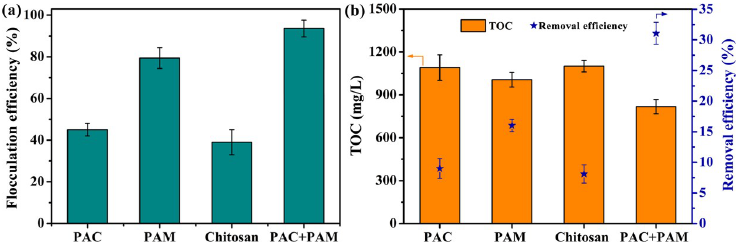
Fig 6. (a) The flocculation efficiency, (b) TOC content and removal efficiency of different flocculants after treating simulated fracturing